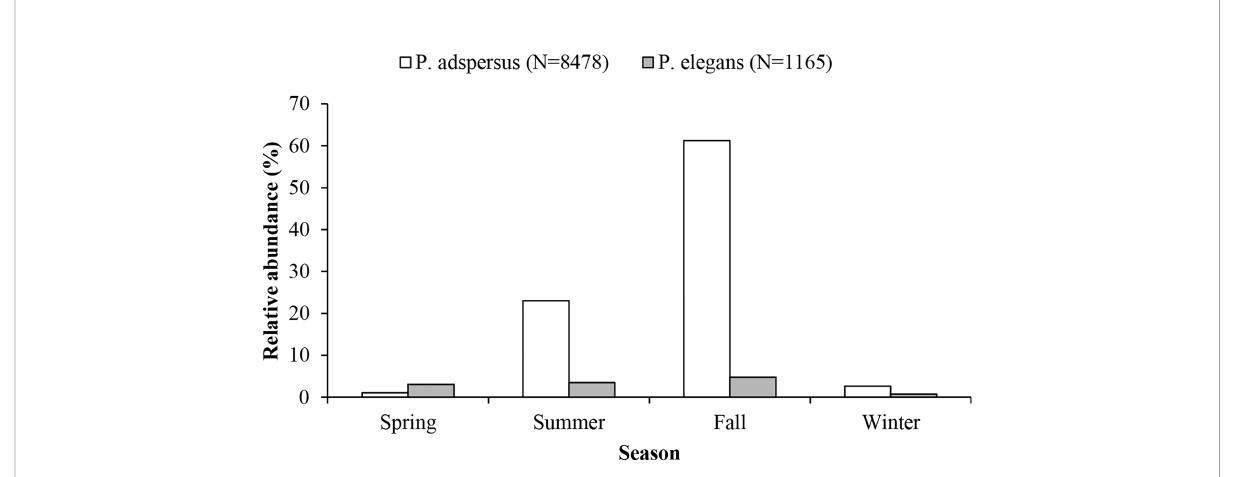
FIGURE 2 Comparison of relative abundance of the shrimps P. adspersus and P. elegans from the southeast Caspian Sea